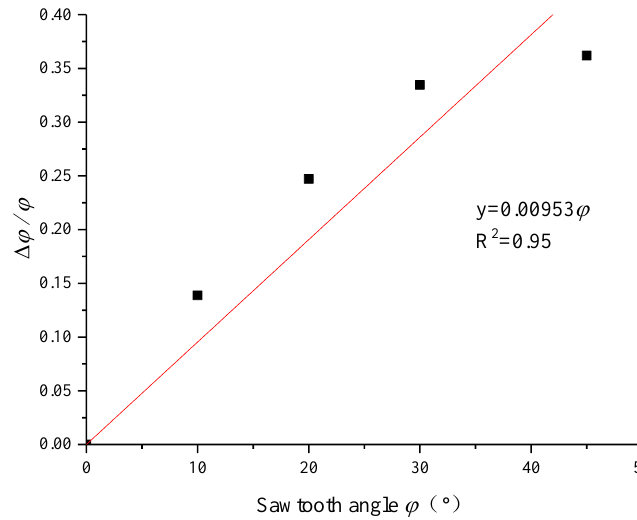
Figure 8. Influence of sawtooth angle on the internal friction